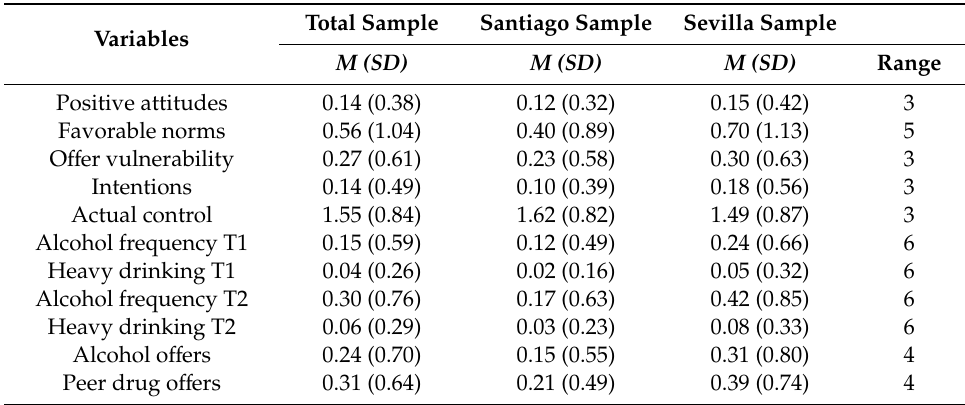
Table 1. Descriptive Statistics of the Main Variables of the Study for the Total Sample and for the Both Cities. Total Sample Santiago Sample Sevilla Variables